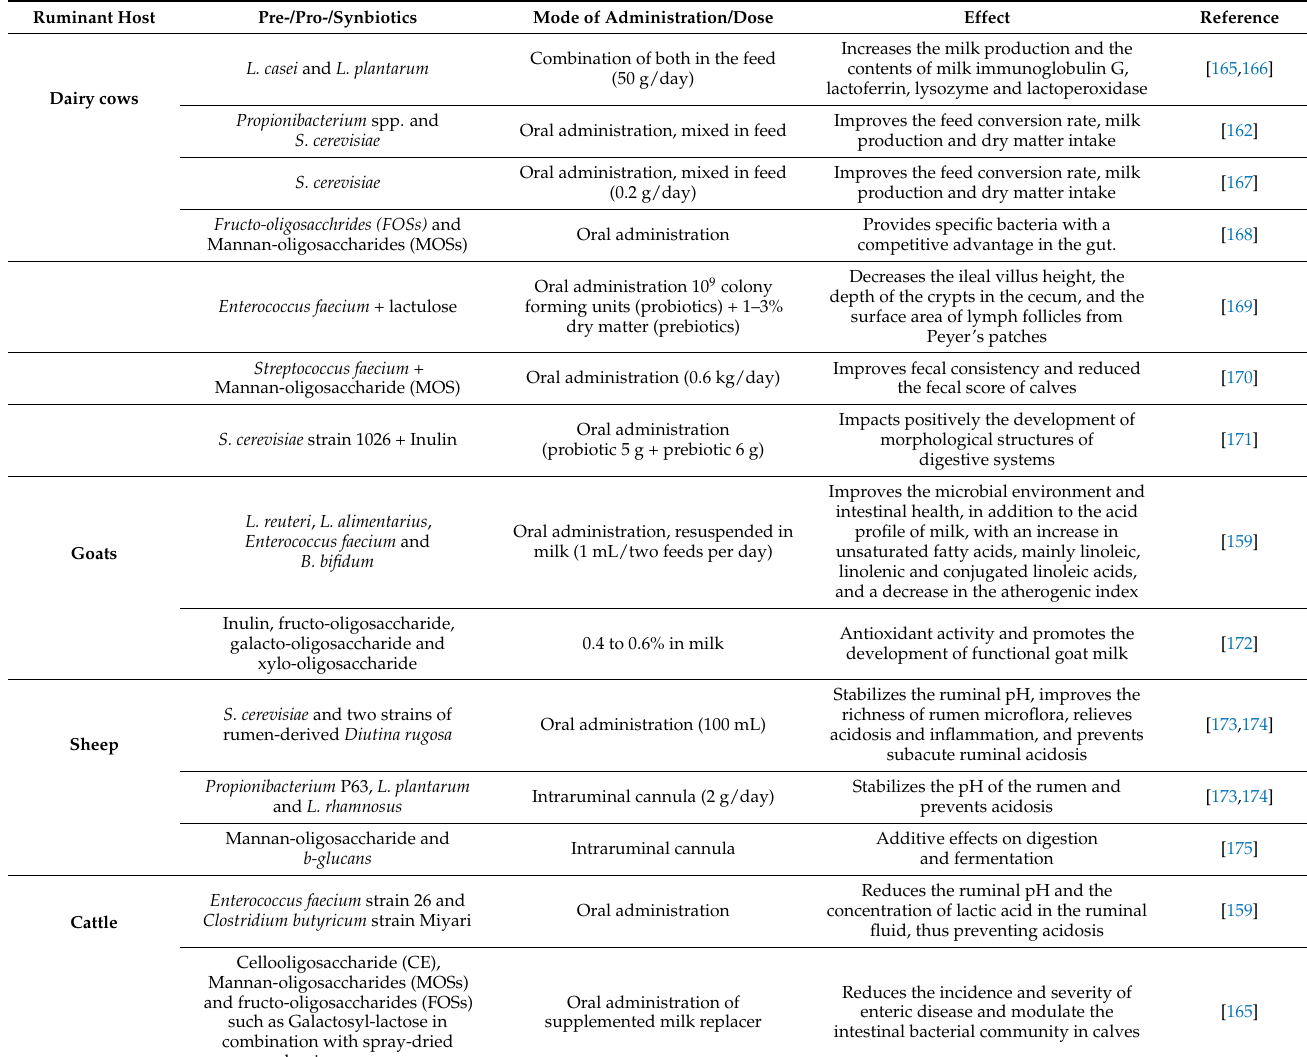
Table 6. Effect of some microbial pre/pro/synbiotics on ruminant